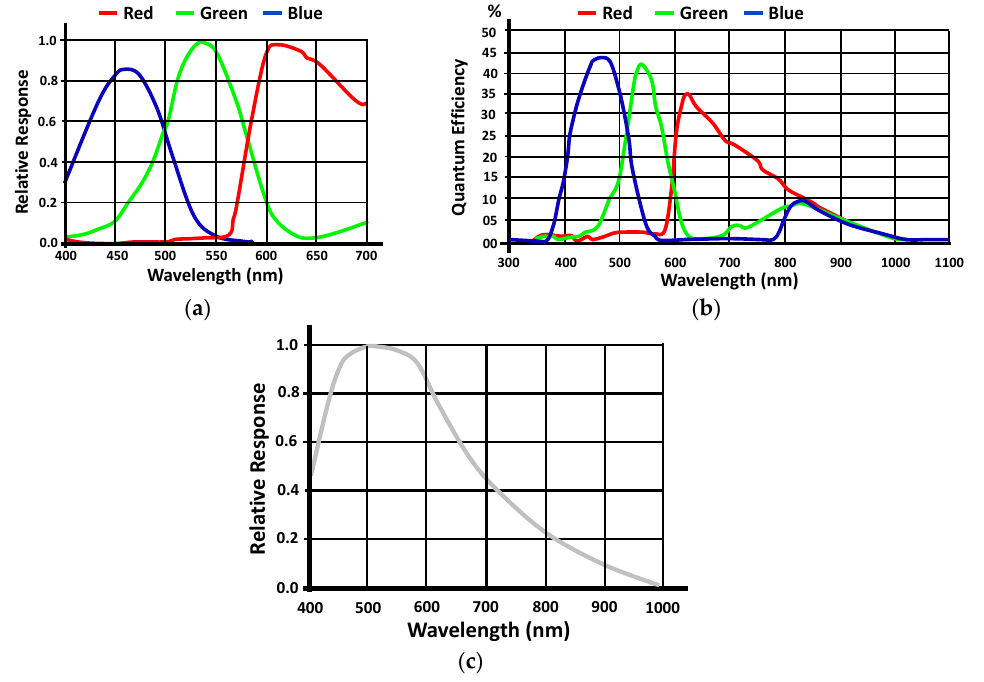
Figure 1. Generic spectral responses: ( a ) Relative Response (RR) for a RGB sensor ; ( b ) Quantum Efficiency (QE) for a RGB sensor ; ( c ) RR for a monochrome sensor.